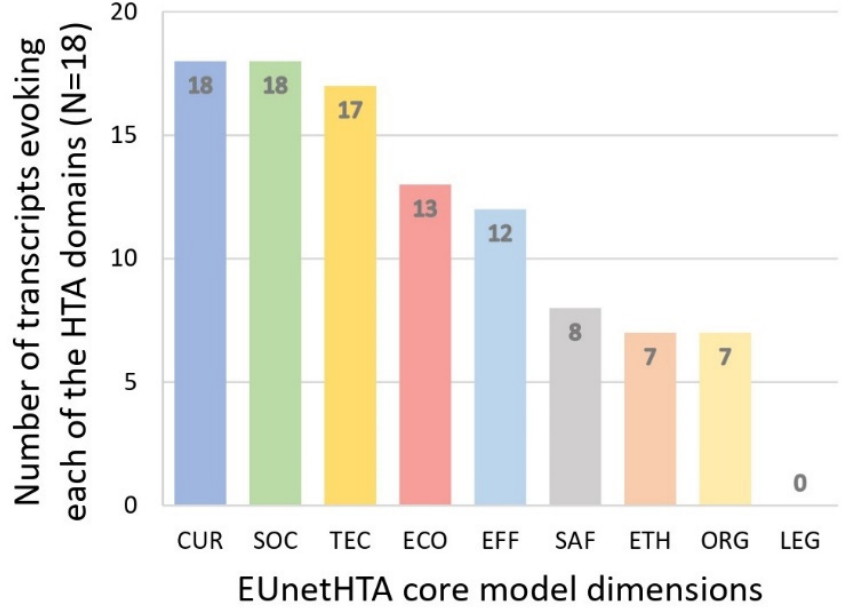
Figure 4. EUnetHTA Core Model ® domains occurrences within the 18 transcripts of the OAs’ inter- views.